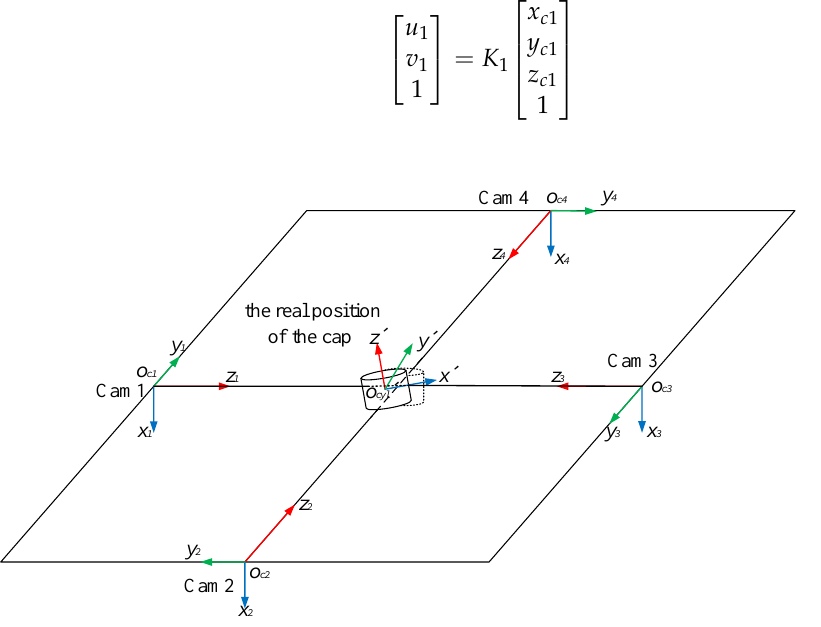
Figure 7. The actual pose of the cap.